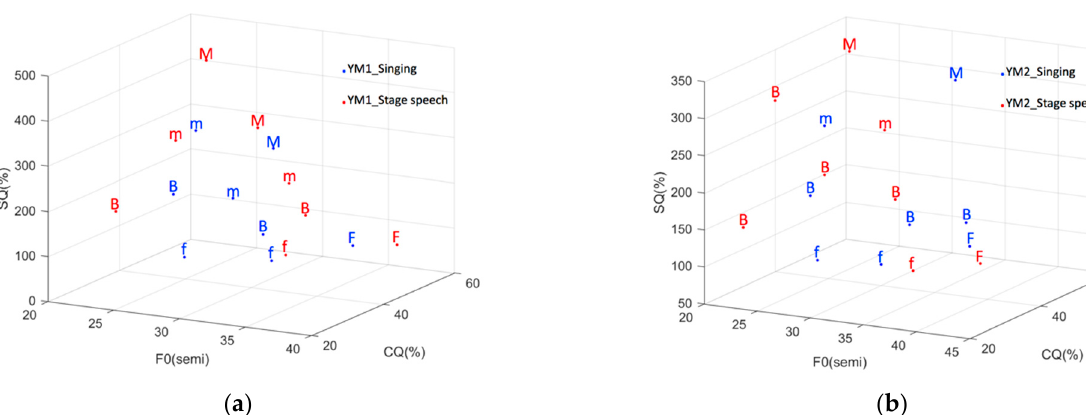
Figure 7. Three-dimensional diagrams of the clustering centroids: ( a ) the parameters of YM1, and ( b ) the parameters of YM2. m: modal; M: high adduction modal; B: breathy; f: untrained falsetto; F: high adduction falsetto.